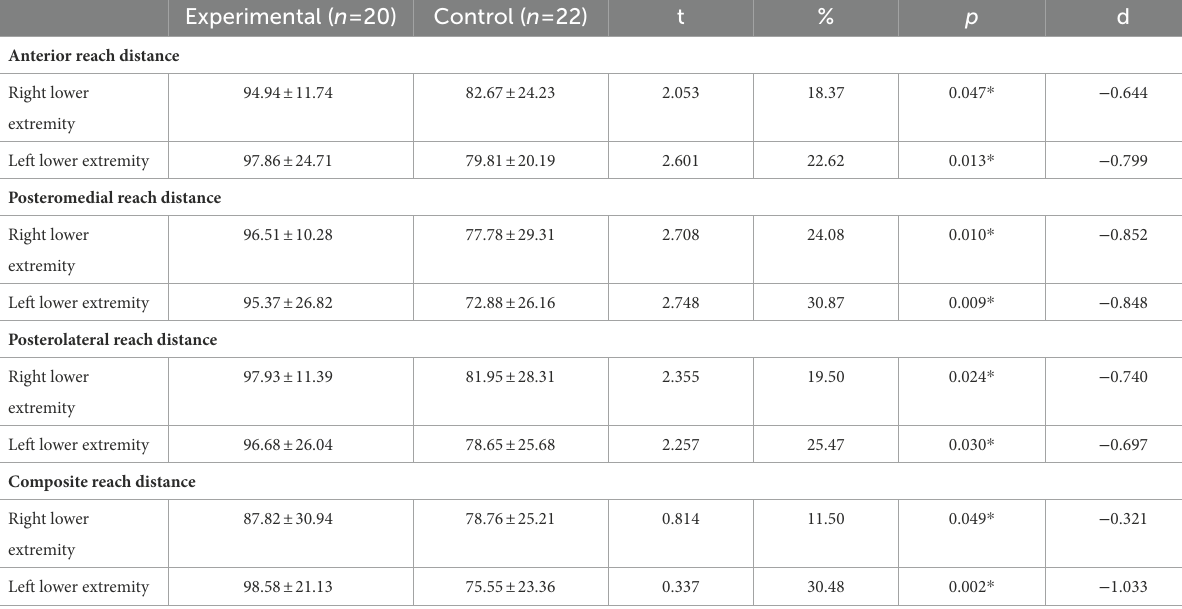
TABLE 3 The results of the independent sample T -test, which was conducted to determine whether there is a significant difference between the balance motor performance capacity post-test Y Balance Test ANT, PM, PL and composite reach distance mean scores of the experimental and control groups.